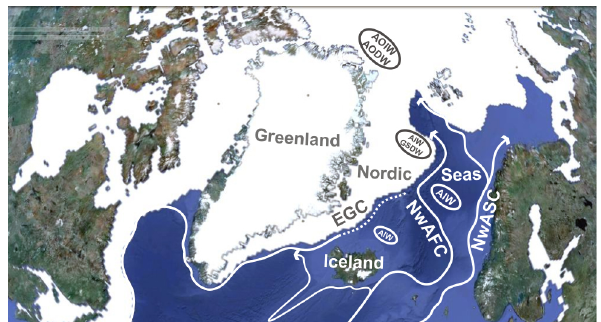
Figure 11. Maximum sea-ice extent in March 1980 (Fetterer et al., 2002, updated 2009; Google Earth). The approximate location of the modern convection sites in the Nordic Seas and the Arctic Ocean are marked by ellipses (Hansen and Østerhus, 2000). The modern (sub)surface-current system in the northern North Atlantic Ocean and the Nordic Seas is also shown (Orvik and Niiler, 2002). The two branches of the Atlantic Inflow into the Nordic Seas (or the Norwegian Atlantic Current) are the NwASC (Norwegian At- lantic Slope Current) and the NwAFC (Norwegian Atlantic Front Current). EGC: East Greenland Current. Note the pattern of sea-ice growth. While this is a modern-day scenario, since sea-surface tem- peratures are to a large extent controlled by ocean currents, this may have relevance to the